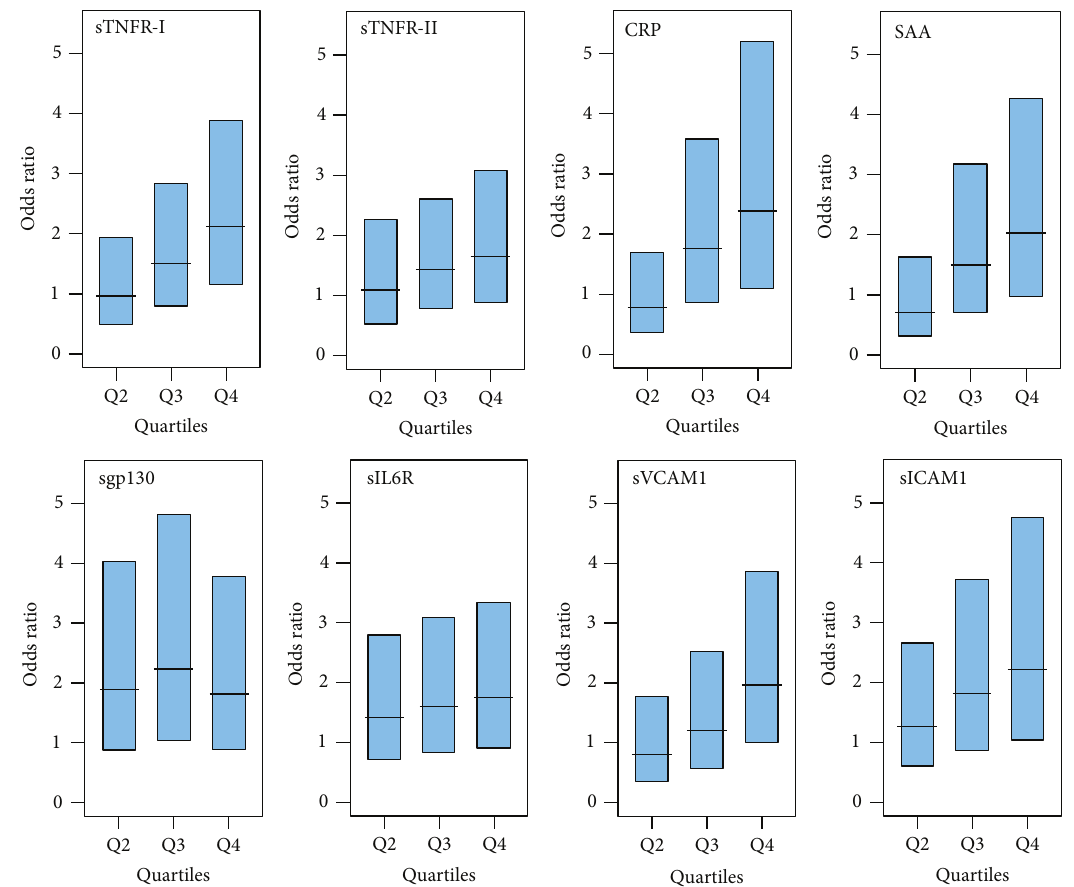
Figure3:StrongassociationofincreasingproteinlevelswithDR.Conditionallogisticregressionwasperformedonmatchedpaireddatausing cases (T1D with DR) and controls (T1D without complication) matched for age, sex, and T1D duration (183 pairs). Subjects were divided into four quartiles based on individual protein levels. The odds ratios and 95% confidence intervals (CI) were computed for each protein using lowest quartile as referent. Compared with subjects in the bottom quartile, subjects in the top quartile had the highest risk of DR for all eight proteins. Also, an increased trend in the risk for DR was observed from quartile-2 to quartile-4 of protein concentrations.